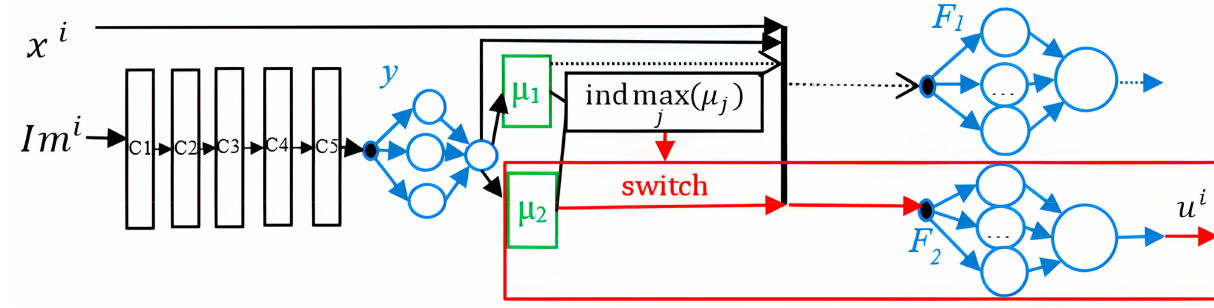
Figure 7. The GMPPT system based on an MFNN. Table 11. Recent comparative studies of ML-based and other MPPT